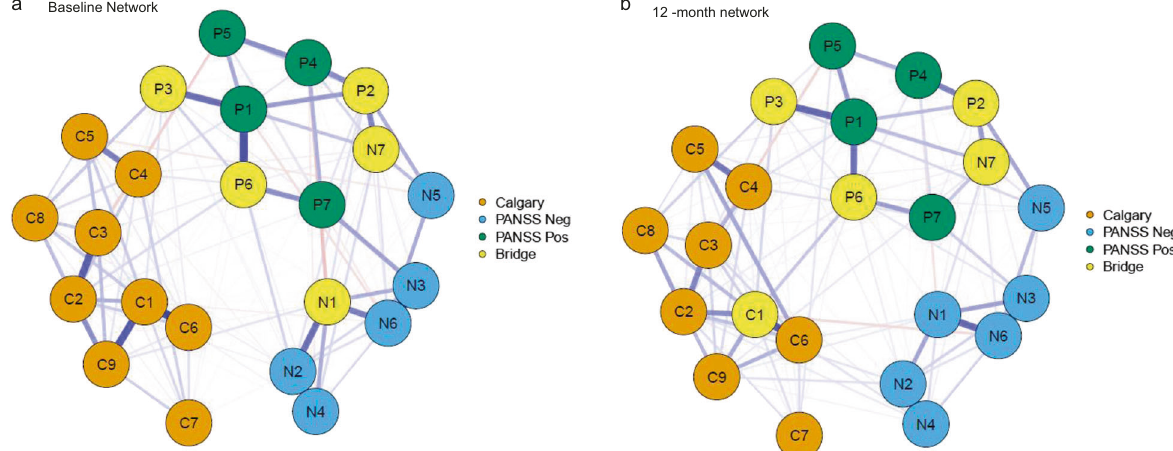
Fig. 3 Top scoring bridge nodes across the networks. Network structures for baseline (3 a ), and 12-months (3 b ), display the top 20% scoring nodes on bridge strength (a cut-off recommended as giving an acceptable balance between sensitivity and speci fi city). Yellow nodes represent the bridge nodes. Orange nodes represent depressive items from the CDSS scale. Blue nodes represent 7 negative symptoms from the PANSS scale, and green nodes represent items from the PANSS positive scale. See Fig. 1 caption for node